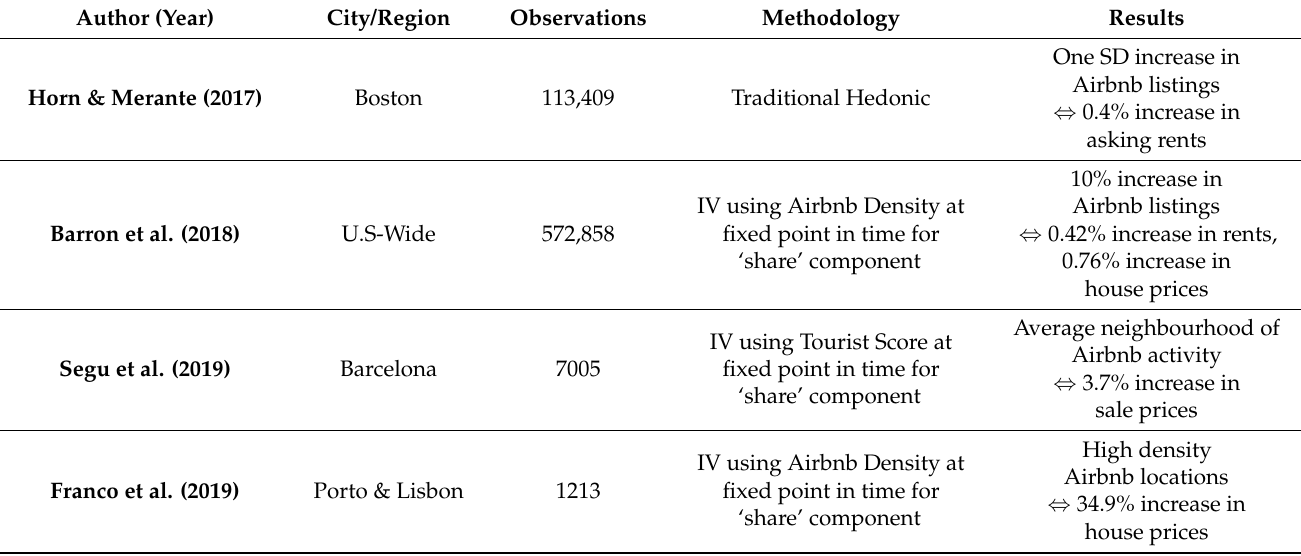
Table A1. Summary of OLS modelling results from previous studies.